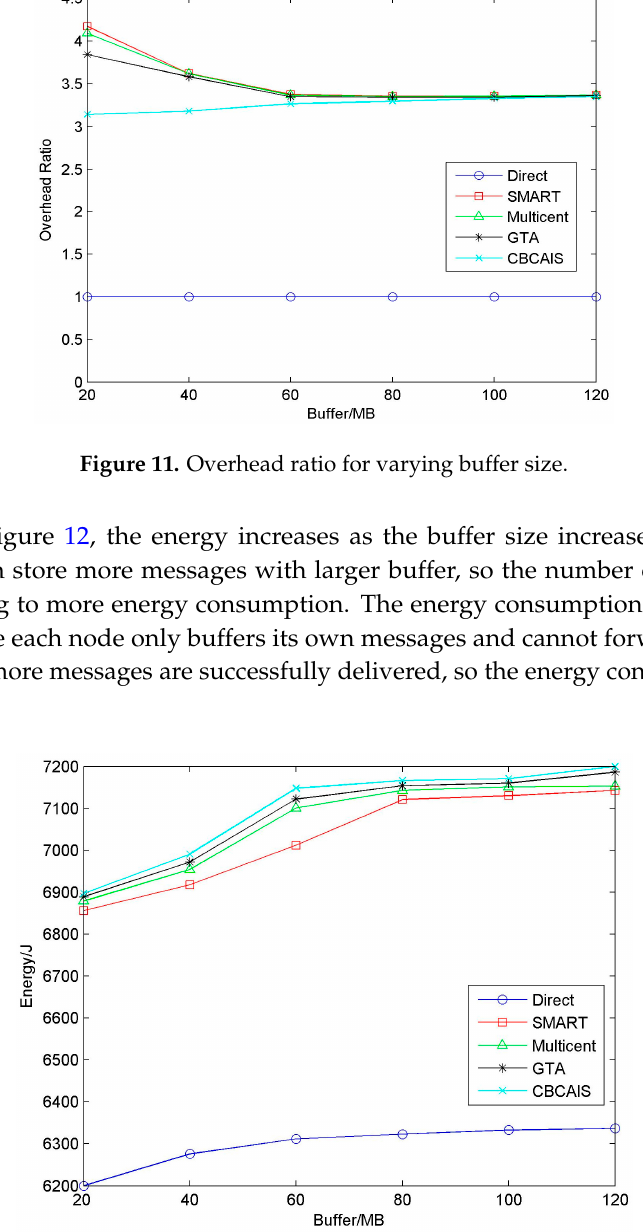
Figure 12. Energy for varying buffer